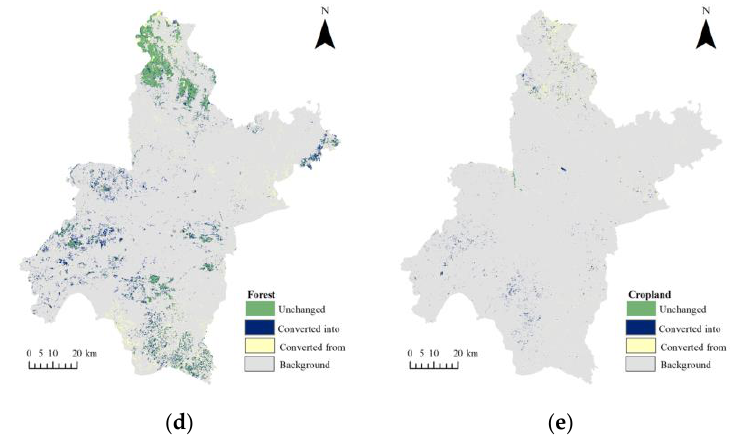
Figure 16. The dynamicity of major land uses in 2029: ( a ) the dynamicity of built-up land; ( b ) the dynamicity of cropland; ( c ) the dynamicity of water; ( d ) the dynamicity of forest; ( e ) the dynamicity of grassland.